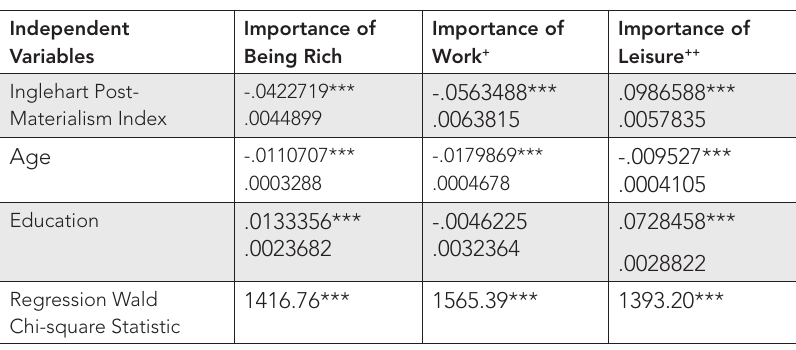
Table 3: Mixed Effects Regressions: Consumption Orientation Indicators (Coefficients and Standard